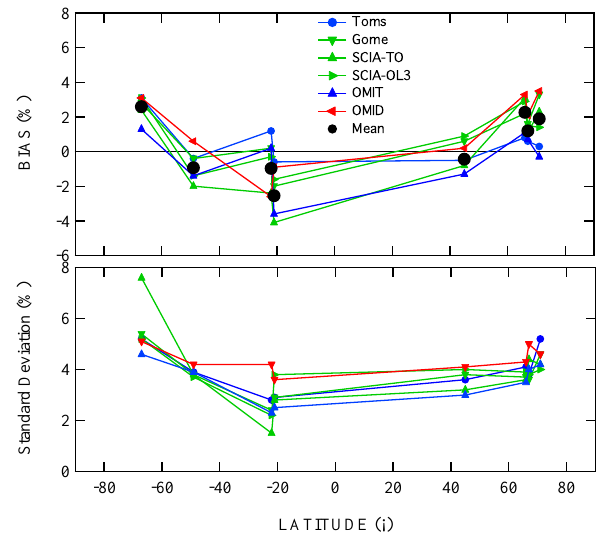
Fig. 14. Latitudinal variation of mean bias (top) and standard devi- ation (bottom) of the relative difference satellite – SAOZ V2. All satellites measurements are showing very similar mean biases with SAOZ, as well as dispersion, with the exception of SCIA-TOSOMI in Dumont d’Urville for an unknown